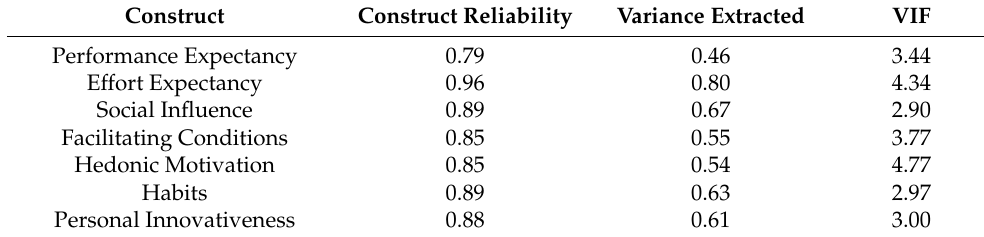
Table 3. Scale reliability of the study